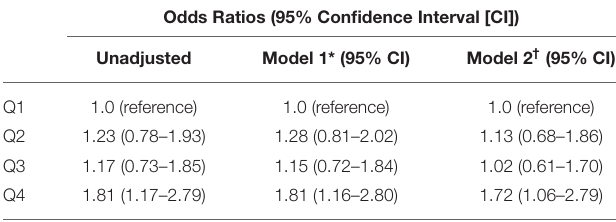
TABLE 3 | Sensitivity analyses of association of QTd with functional outcome (mRS ≥ 3) at 1